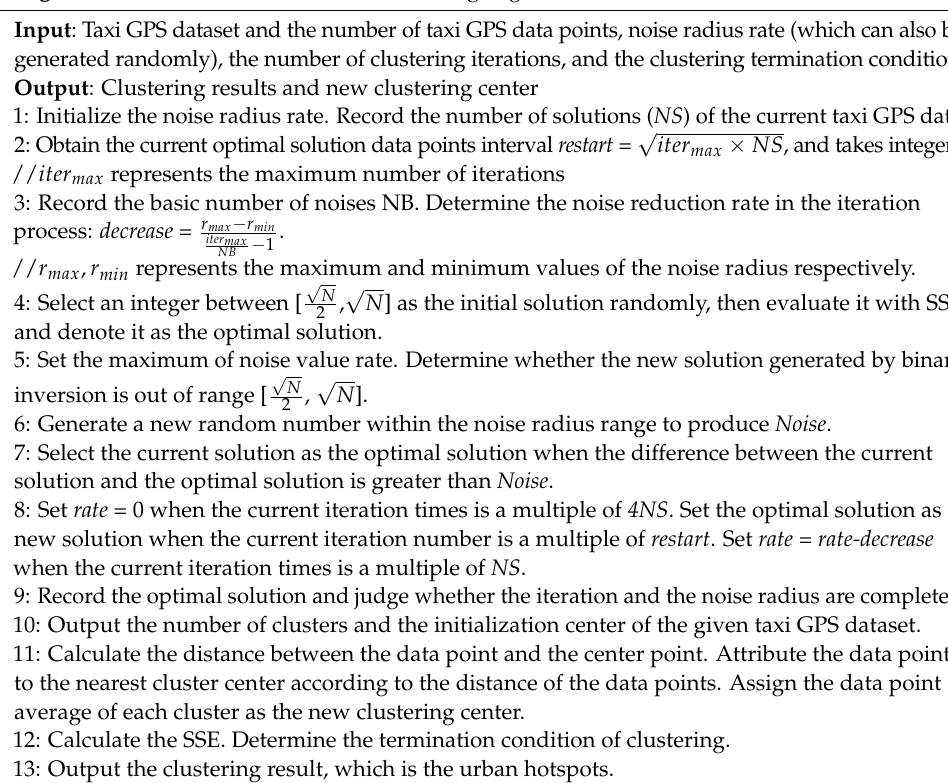
Algorithm 1. Noise-Based K-Means Clustering